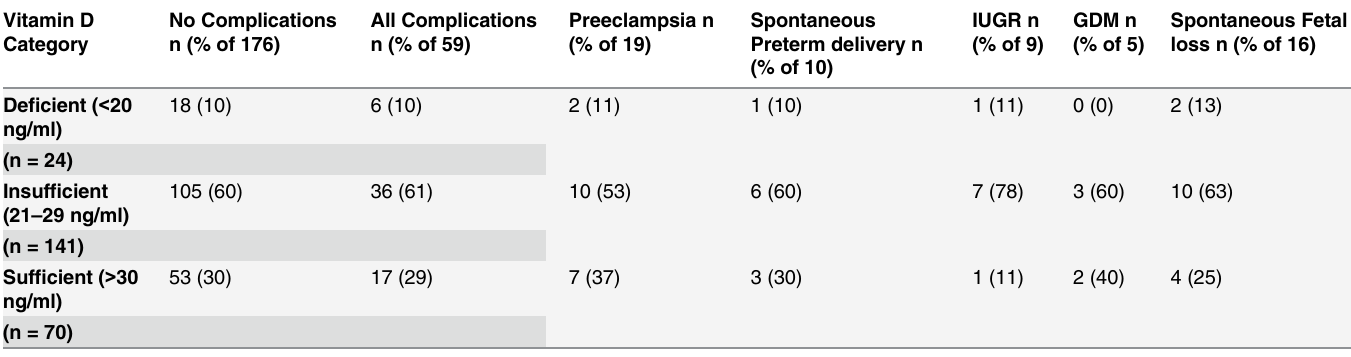
Table 4. Distribution of clinical outcomes in women categorized as Vitamin D deficient, insufficient, or sufficient. Vitamin D No Complications All Complications Category n (% of 176) n (% of